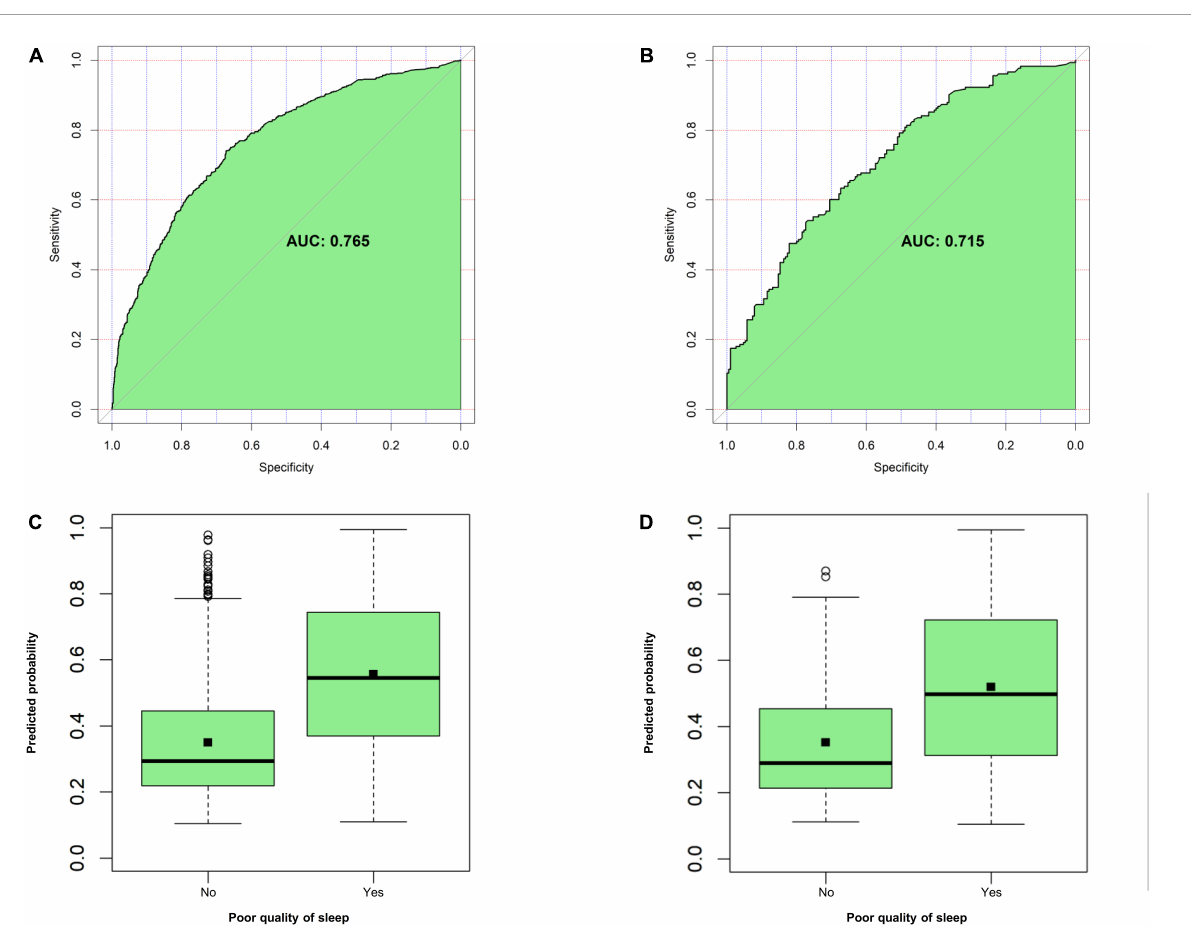
FIGURE3 Evaluation of model’s discrimination. (A) Area under the curve (AUC) for the model in the training group. (B) AUC for the model in the validation group. (C) Discrimination slope for the model in the training group (0.207, P < 0.001). (D) Discrimination slope for the model in the validation group (0.167, P < 0.001). A discriminative plot is plotted with an actual event (yes vs. no) against a predicted probability of poor sleep quality. Discrimination slope is the mean difference of predicted probabilities between participants with actual poor sleep quality and those without